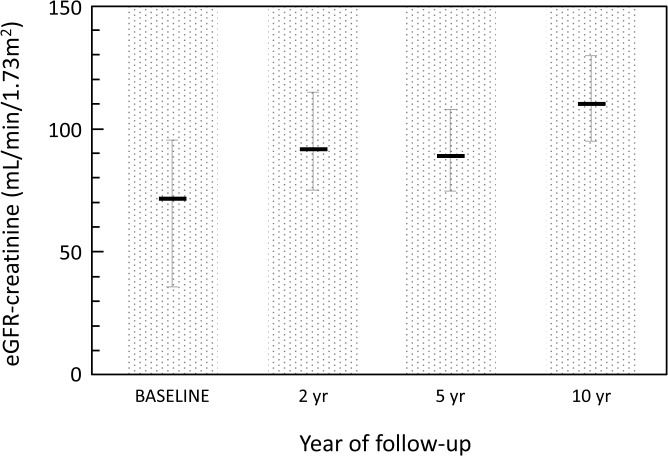
Comparison of the estimated GFR-creatinine values in the cases measured during the follow-up.Values are eGFR-creatinine (mL/min/1.73m2) expressed as median (interquartile range (IQR). The overall comparison between groups using the Friedman’s test was significant (p <0.001) and the multiple comparison tests (Wilcoxon’s test with Bonferroni’s correction (p level of significance: <0.020) yielded the following results for the pairwise comparisons: baseline vs. 2 yrs: p<0.001, baseline vs. 5 yrs: p = 0.005, baseline vs. 10 yrs: p<0.001; 2 yrs vs. 5 yrs: p = 0.835, 2 yrs vs. 10 yrs: 0.008; 5 yrs vs. 10 yrs: p<0.001.